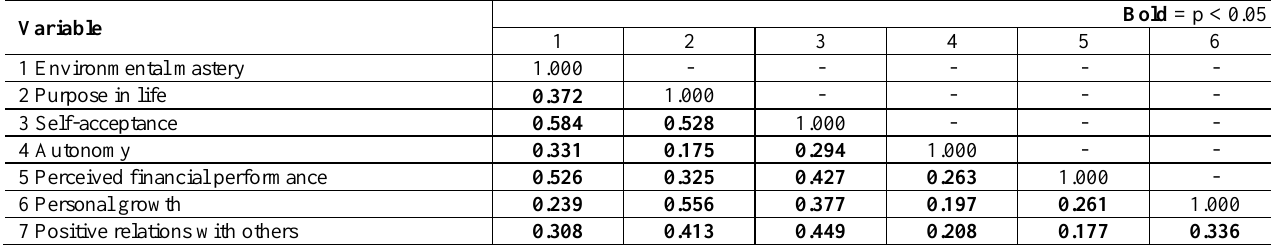
Table 5: Pearson’s correlation coefficient